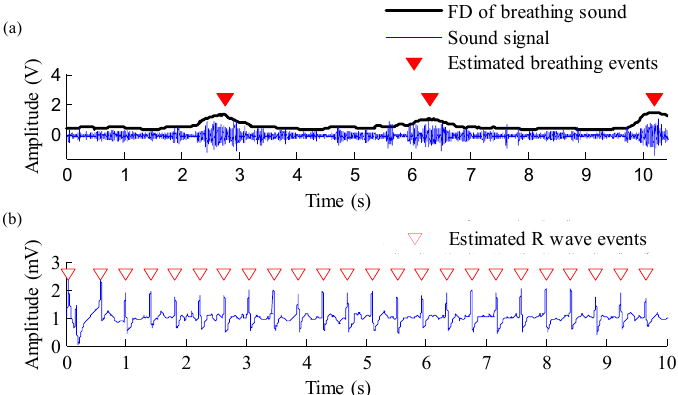
Figure 7. ( a ) Raw signal of breathing sound and estimated breathing events, and ( b ) raw signal of ECG signal and estimated R-wave events.